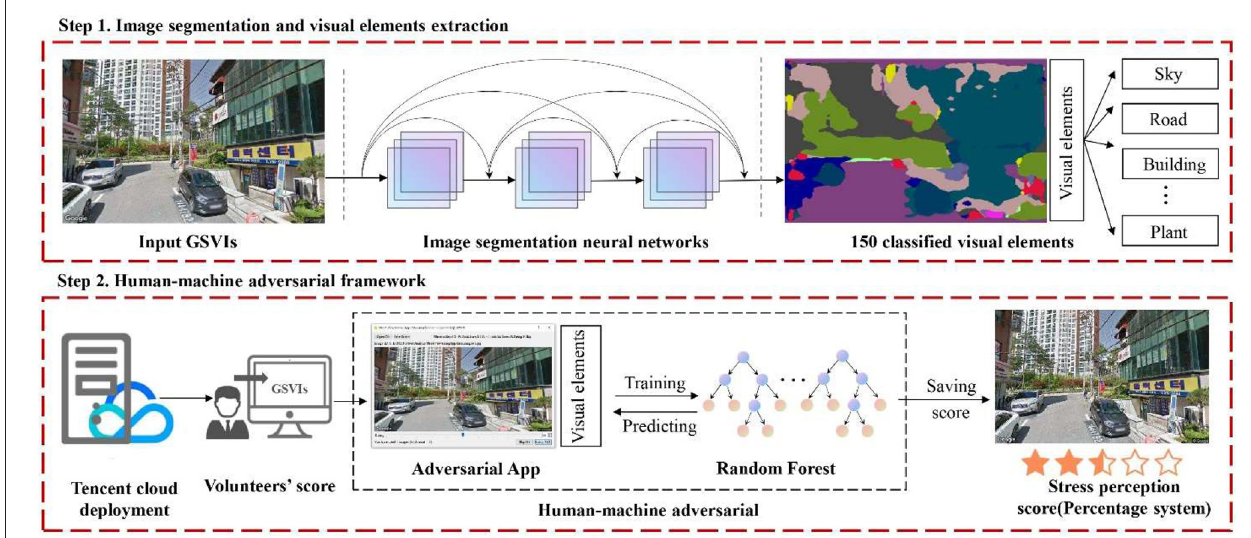
FIGURE 5 | Perceived stress calculation for urban streets based on a human–machine adversarial